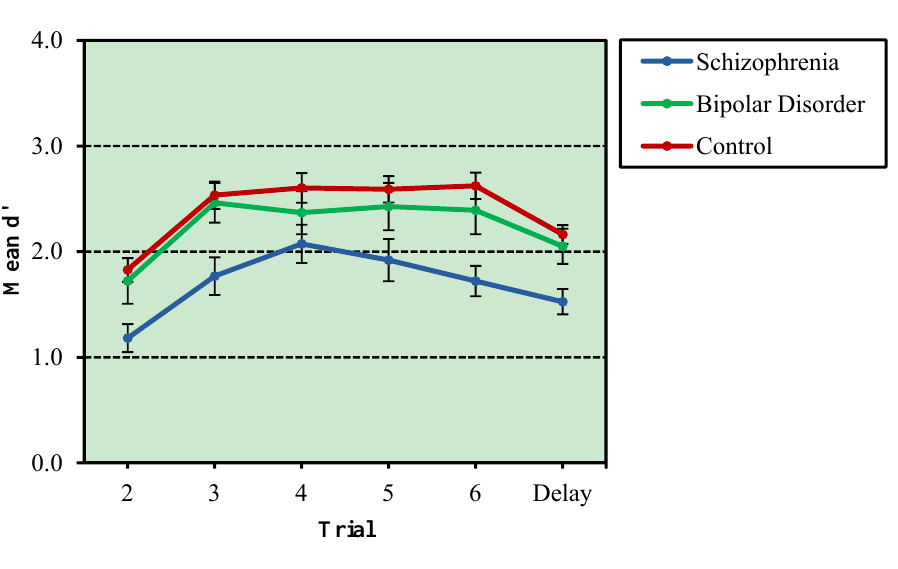
Figure 1. Mean d' across Trials 2–6 and delayed trials (7–8) for the Recurring Figures Test for probands with schizophrenia and bipolar disorder, as well as nonpsychiatric controls. Schizophrenia probands were significantly lower in recognition discrimination (d ' ) compared to bipolar disorder and control probands, and performance on Trial 2 was significantly lower than other trials. There was no interaction of group and trial